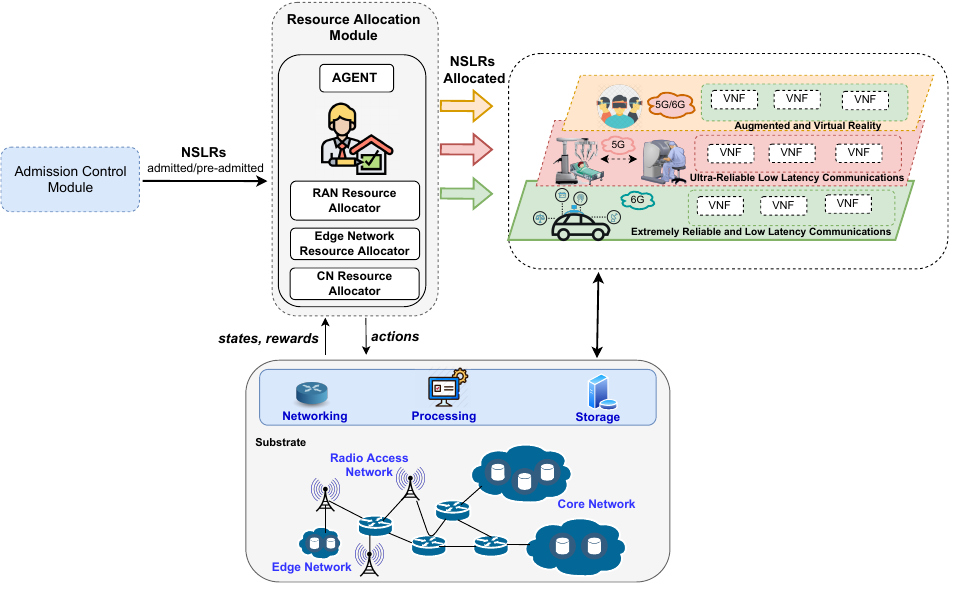
Figure 4. Resource allocation architecture using